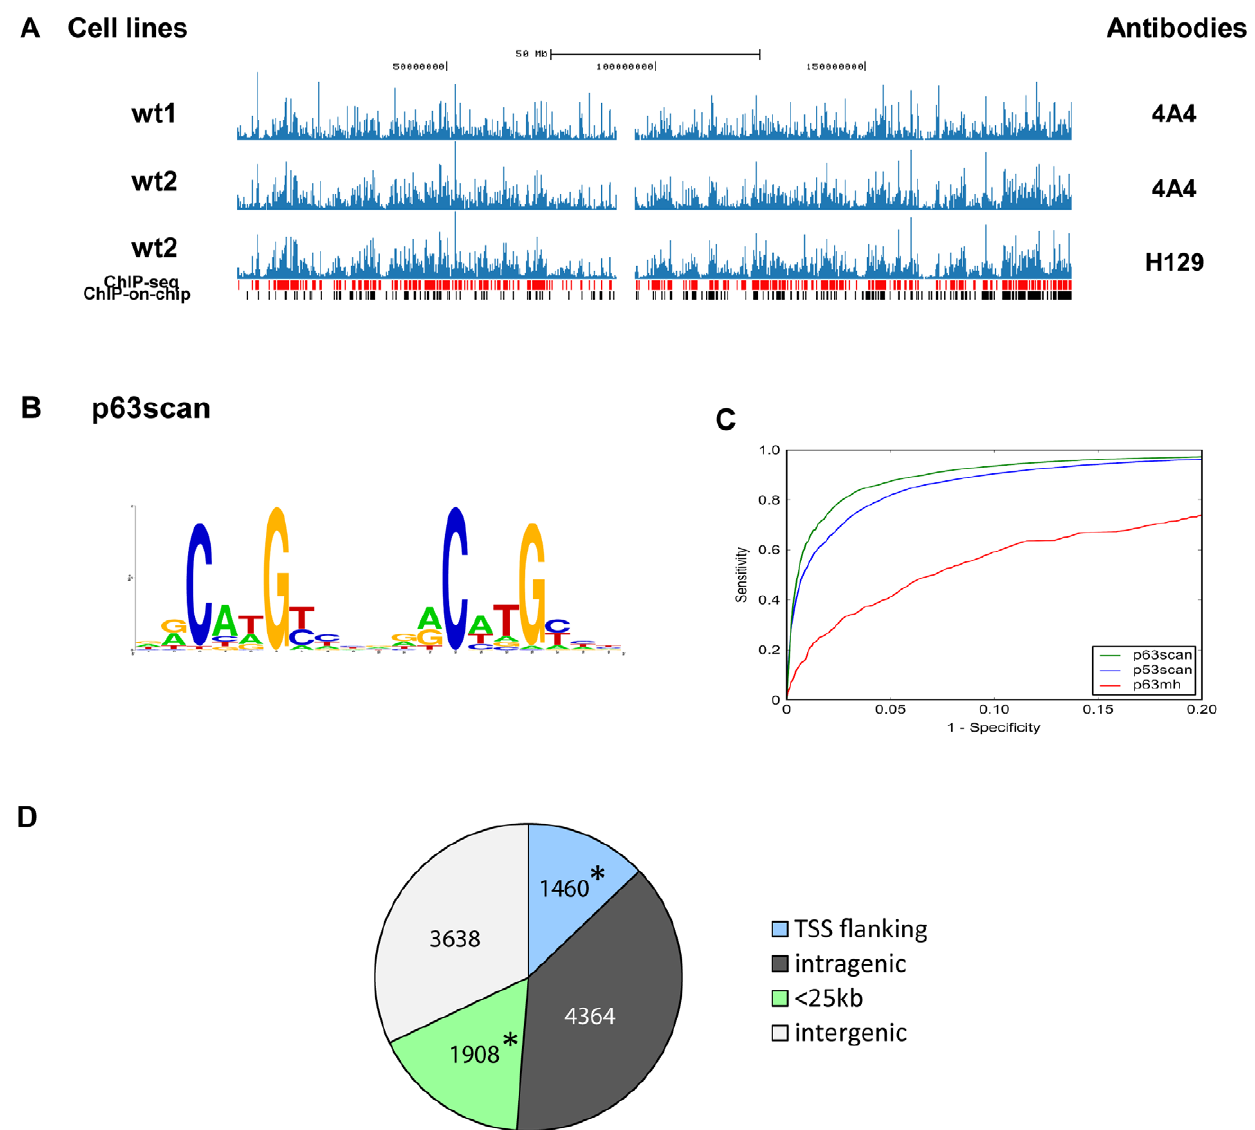
Figure 1. Characterization of identified p63 binding sites. (A) A screenshot of chromosome 3 using UCSC genome browser shows similar DNA-binding profiles from our ChIP-seq analysis of two normal human primary keratinocyte cell lines (wt1 and wt2) with two different antibodies (4A4, pan-p63 and H129, a -specific). The p63 binding sites analyzed with MACS [35] using P value 1 6 10 2 9 are shown in red, and previously reported p63 binding sites in ChIP-on-chip analysis [17] are shown in black. (B) The p63 motif was identified by a de novo motif analysis (see Materials and Methods). Based on a previously developed p53scan algorithm [37] with this newly identified p63 Positional Weight Matrix (PWM), p63scan was developed. (C) The performance of p63scan using the de novo identified motif shows superior sensitivity compared to previously reported p63MH without compromising specificity. (D) Distribution of the p63-binding site location relative to RefSeq genes. Locations of binding sites are divided into: TSS flanking region (5 kb upstream of TSS, first exon and first intron), intragenic region (all introns and exons except first), , 25 kb (5–25 kb upstream or 25 kb downstream of last exon), or intergenic regions (everything else). The asterisk represents significant enrichment. doi:10.1371/journal.pgen.1001065.g001 motif scores correlated with an increase of peak heights of the (Figure 1B, Table S2). An additional significant AP1-like motif binding sites (Figure S2), suggesting a stronger binding of p63 to that can be bound by c-Fos and c-Jun proteins [38] was also binding sites with higher motif scores. Using p63scan, 10,702 out identified in the detected binding sites ( P , 1E-50, Table S2). We of a total 11,369 p63 binding sites (94%) were found to contain at combined our previously developed p53scan algorithm [37] with least one p63 motif (motif score 4.74, False Discovery Rate, FDR the newly identified p63 PWM, hereafter referred to as p63scan. 10%). The high percentage of motif-containing binding sites Comparison of p63scan with the previously described motif indicates that most binding sites identified in this study participate algorithms p63MH [36] and p53scan [37] showed that p63scan in direct binding of p63. The de novo consensus motif prediction had clearly higher sensitivity for motif recognition without pipeline was applied to the subgroup of binding sites without p63 compromising the specificity (Figure 1C). A slight increase of binding motifs to search for consensus motifs of other transcription